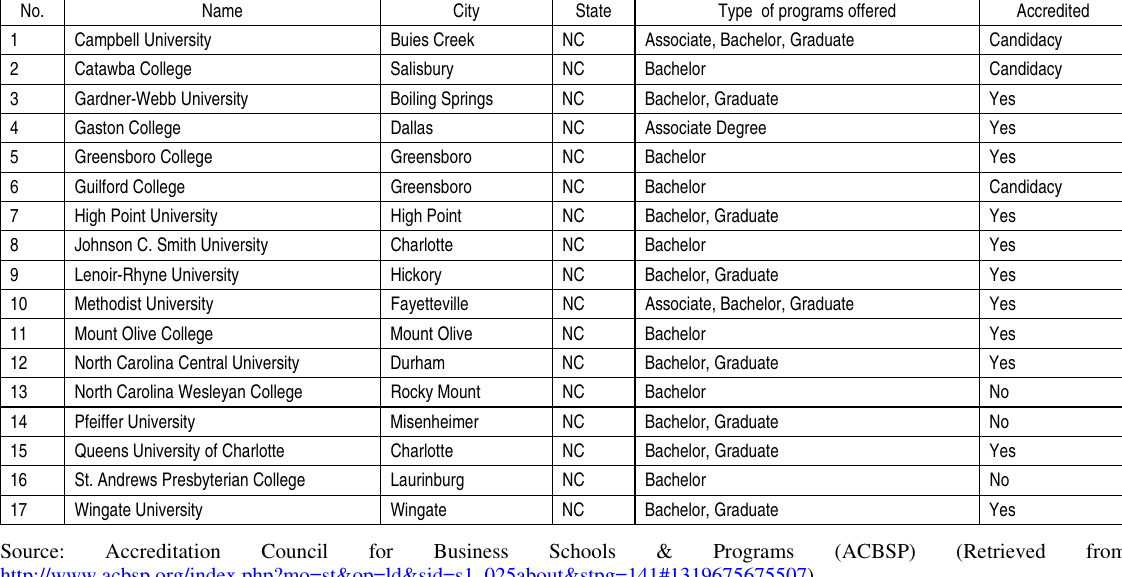
Table 1. NC colleges and universities listed at the ACBSP website (November 5, 2011) No.